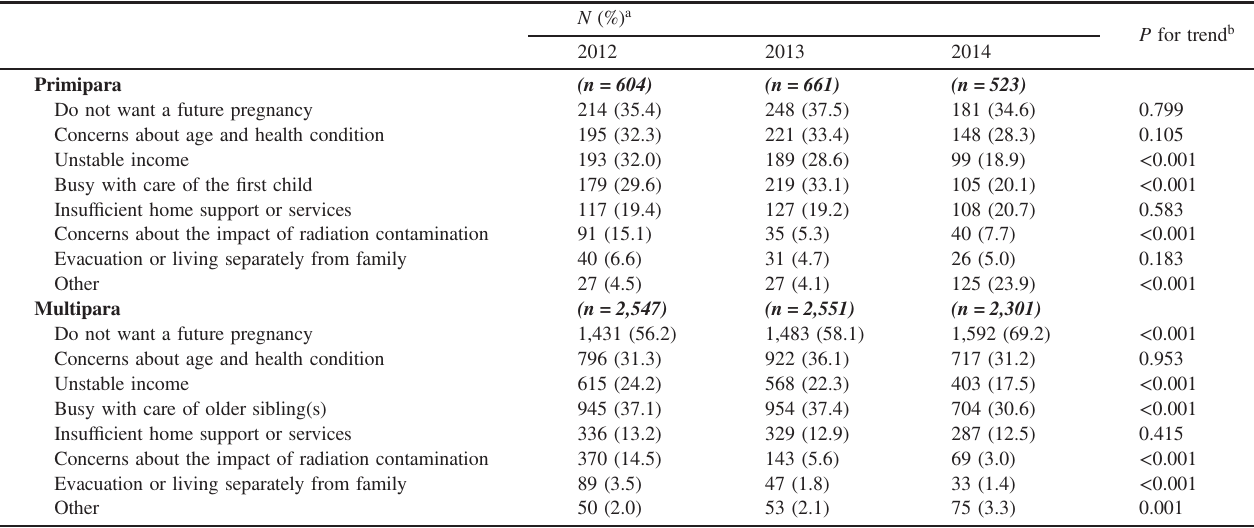
Table 4. Reasons for no intention of future pregnancy by parity